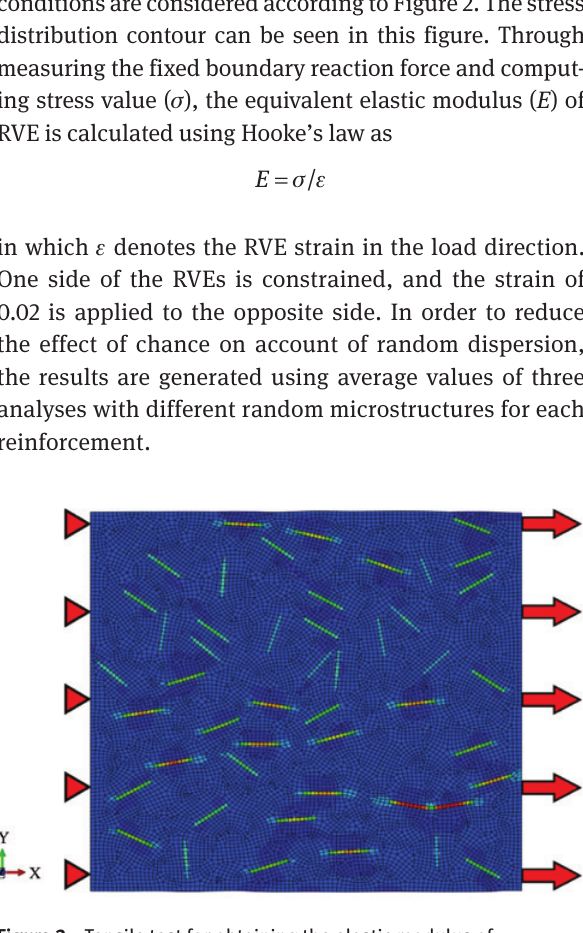
Figure 2: Tensile test for obtaining the elastic modulus of